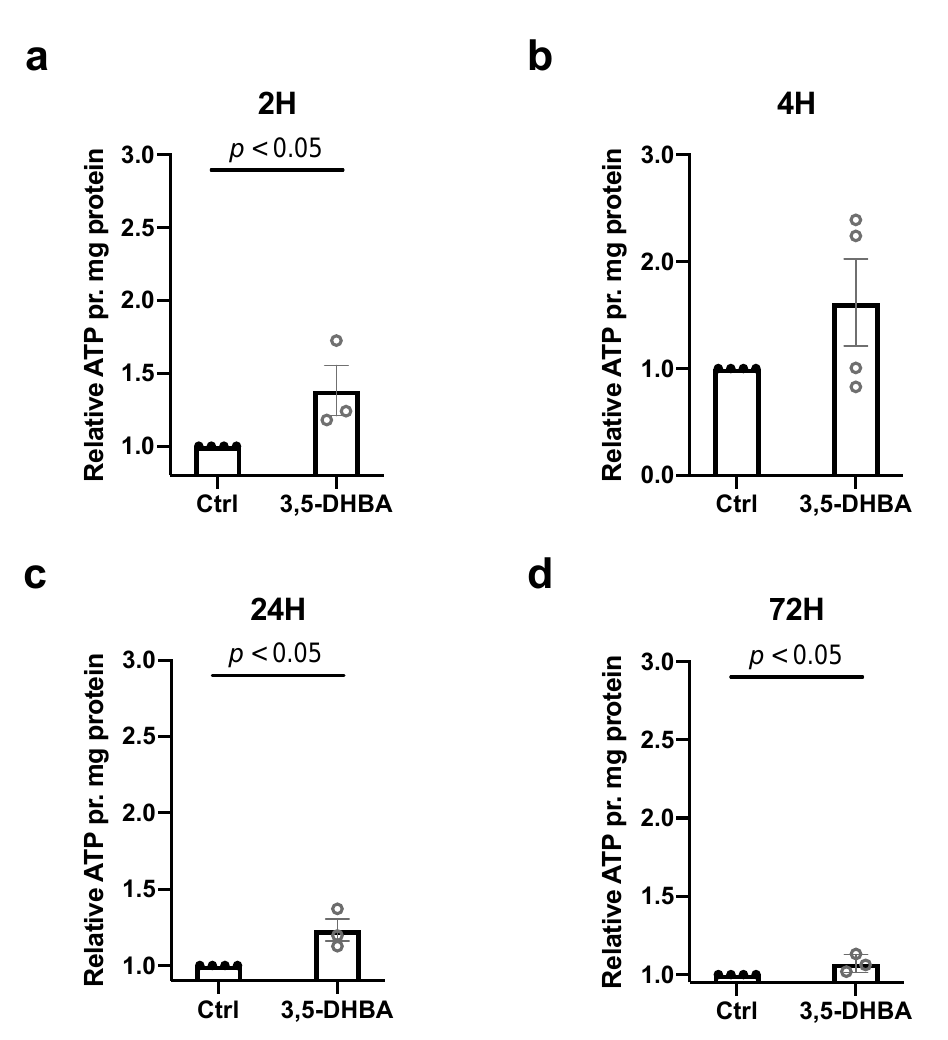
Figure 3. ATP levels in retinal explants are increased in response to 3,5-DHBA treatment. ( a – d ) Intracellular content of ATP measured in retinal explants incubated for 2, 4, 24, and 72 h via the Bioluminescent Somatic Cell Assay Kit. ATP levels increase during 2, 24, and 72 h of incubation with 3,5-DHBA compared to controls. Values are normalized to mg of protein in each sample. Values are presented as mean ± S.E.M ( n = 3 – 4 retinal quarters originating from three to four different whole retinas). Statistics: Unpaired t -test.